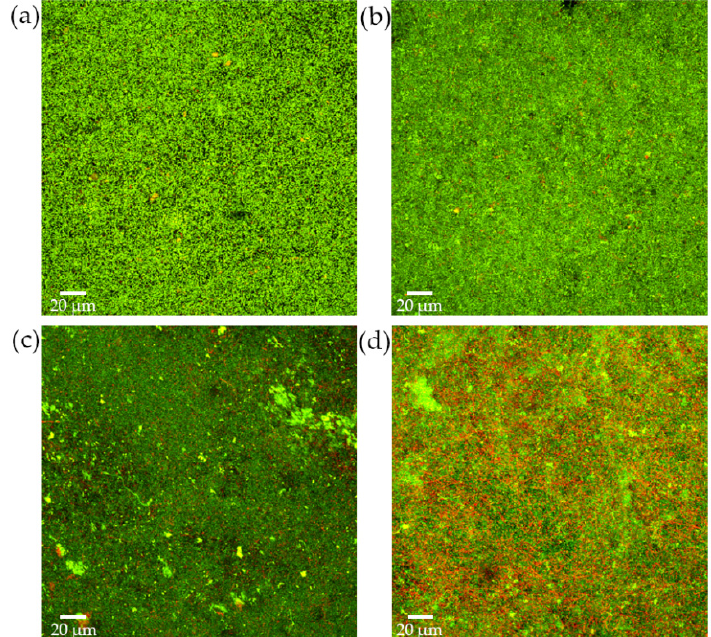
Figure 6. Analysis by confocal laser scanning microscopy of: ( a , b ) 24-h biofilms exposed for 24 h to 1 mL of brain heart infusion (BHI) medium (control biofilms) and to 1 mL of 10 8 colony forming units (CFU) mL − 1 of S. downii sp. nov. in fresh BHI medium (exposed biofilms), respectively; ( c , d ) 24-h biofilms exposed for 48 h to 1 mL of BHI medium (control biofilms) and to 1 mL of 10 8 CFU mL − 1 of S. downii sp. nov., in fresh BHI medium (exposed biofilms),